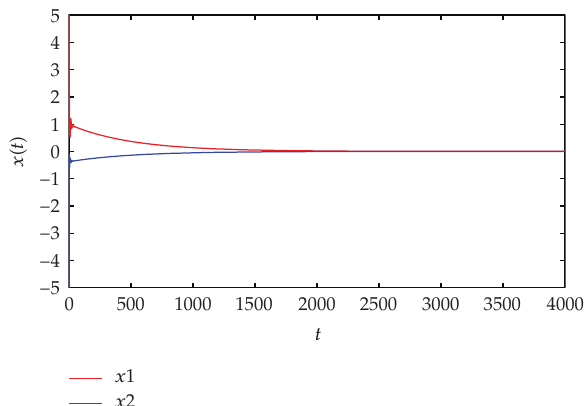
Figure 3: State trajectories of system (cid:2) 12 (cid:3) with cc (cid:9) 0 . 4 , τ 1 (cid:9) τ 2 (cid:9) 0 . 3 , h (cid:9) 2 . 61 , E a (cid:9) E b (cid:9) E d (cid:9) 0